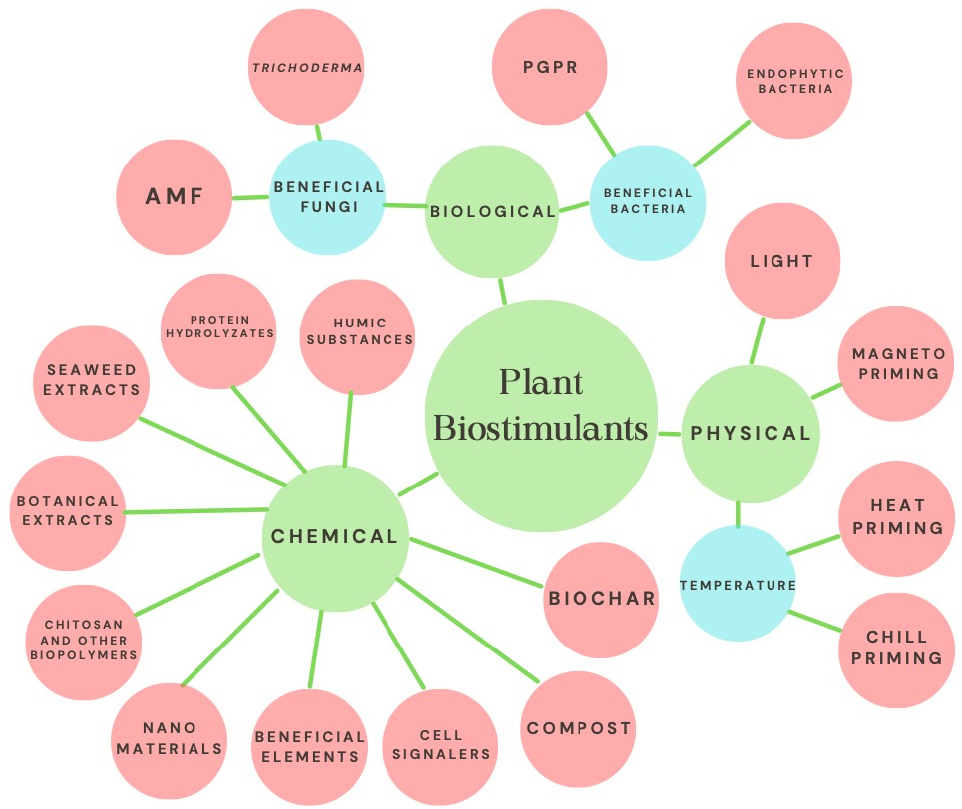
Figure 1. Main categories of biostimulants considered in this review. AMF: Arbuscular mycorrhizal fungi; PGPR: Plant growth-promoting rhizobacteria; Cell signalers: H 2 O 2 , H 2 S, NO. Figure prepared by the authors with information from various sources [4–7].